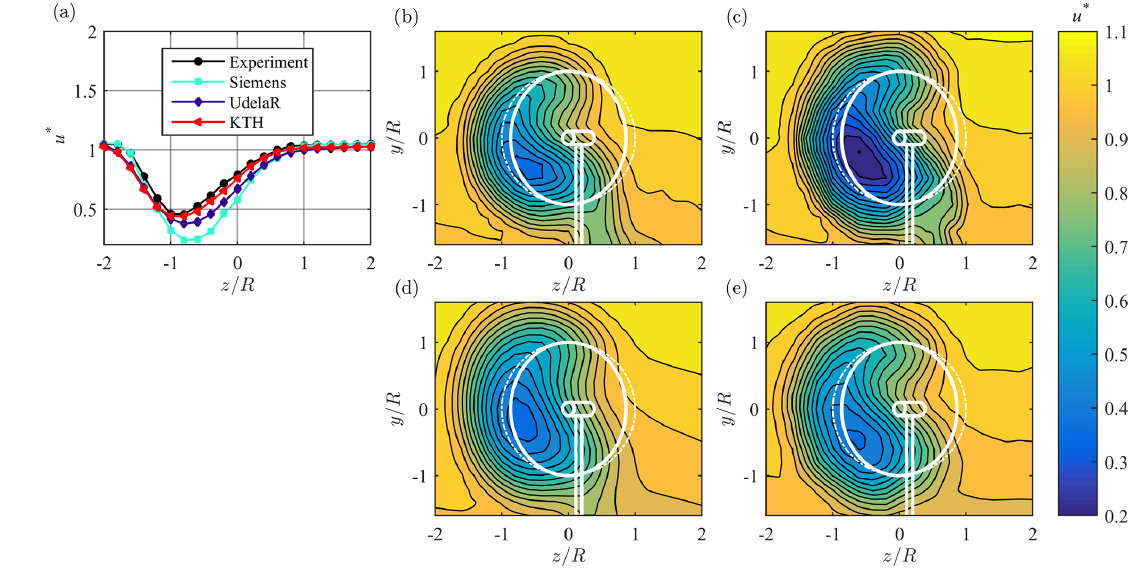
Figure 14. (a) Line plot at hub height and (b–e) contour plots for normalized streamwise mean velocity u ∗ in the wake 3 D behind ForWind turbine, from (b) experiments, (c) Siemens, (d) UdelaR, and (e) KTH. The white lines represent the turbine rotor, nacelle, and tower; solid lines γ = 30 ◦ ; dashed lines γ = 0 ◦ .